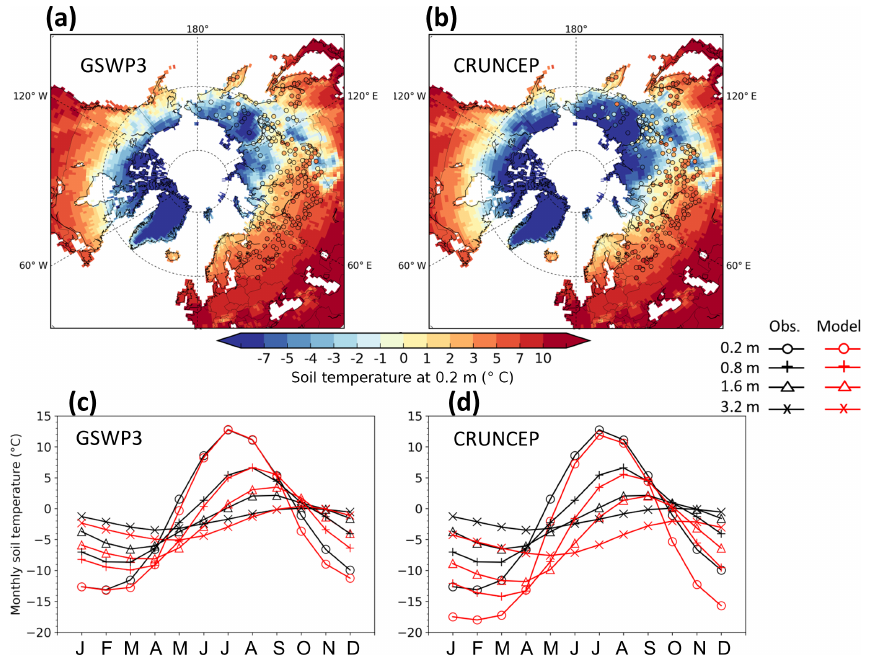
Figure 5. Mean annual soil temperature at 0.2m depth ( ◦ C) in the (a) GSWP3 and (b) CRUNCEP-forced simulations (background maps), compared to the site observations (color filled circles), averaged over the period 1981–2000. Monthly mean seasonal soil temperatures at different depths ( ◦ C) in the (c) GSWP3 and (d) CRUNCEP-forced simulations, compared with the observation, averaged over the 51 sites in continuous permafrost region (according to the IPA map) and over the period 1981–2000. The spatial patterns of maximum monthly soil temperature are also shown in Fig. S4.